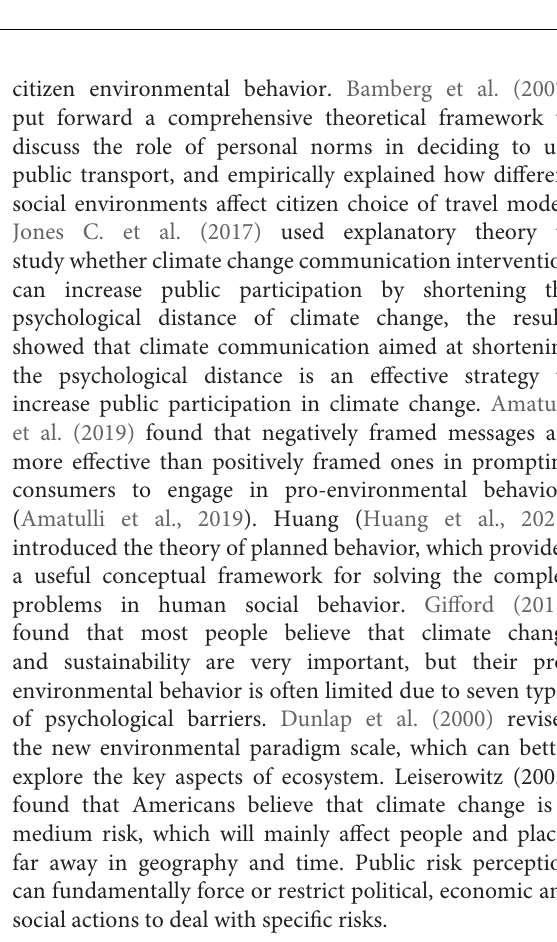
FIGURE 3 | Visualization atlas of literature co-citation